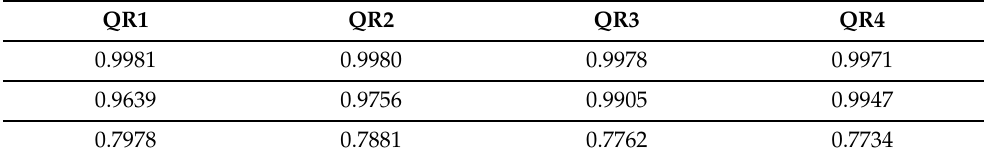
Table 1. Pole localization for each QR case.